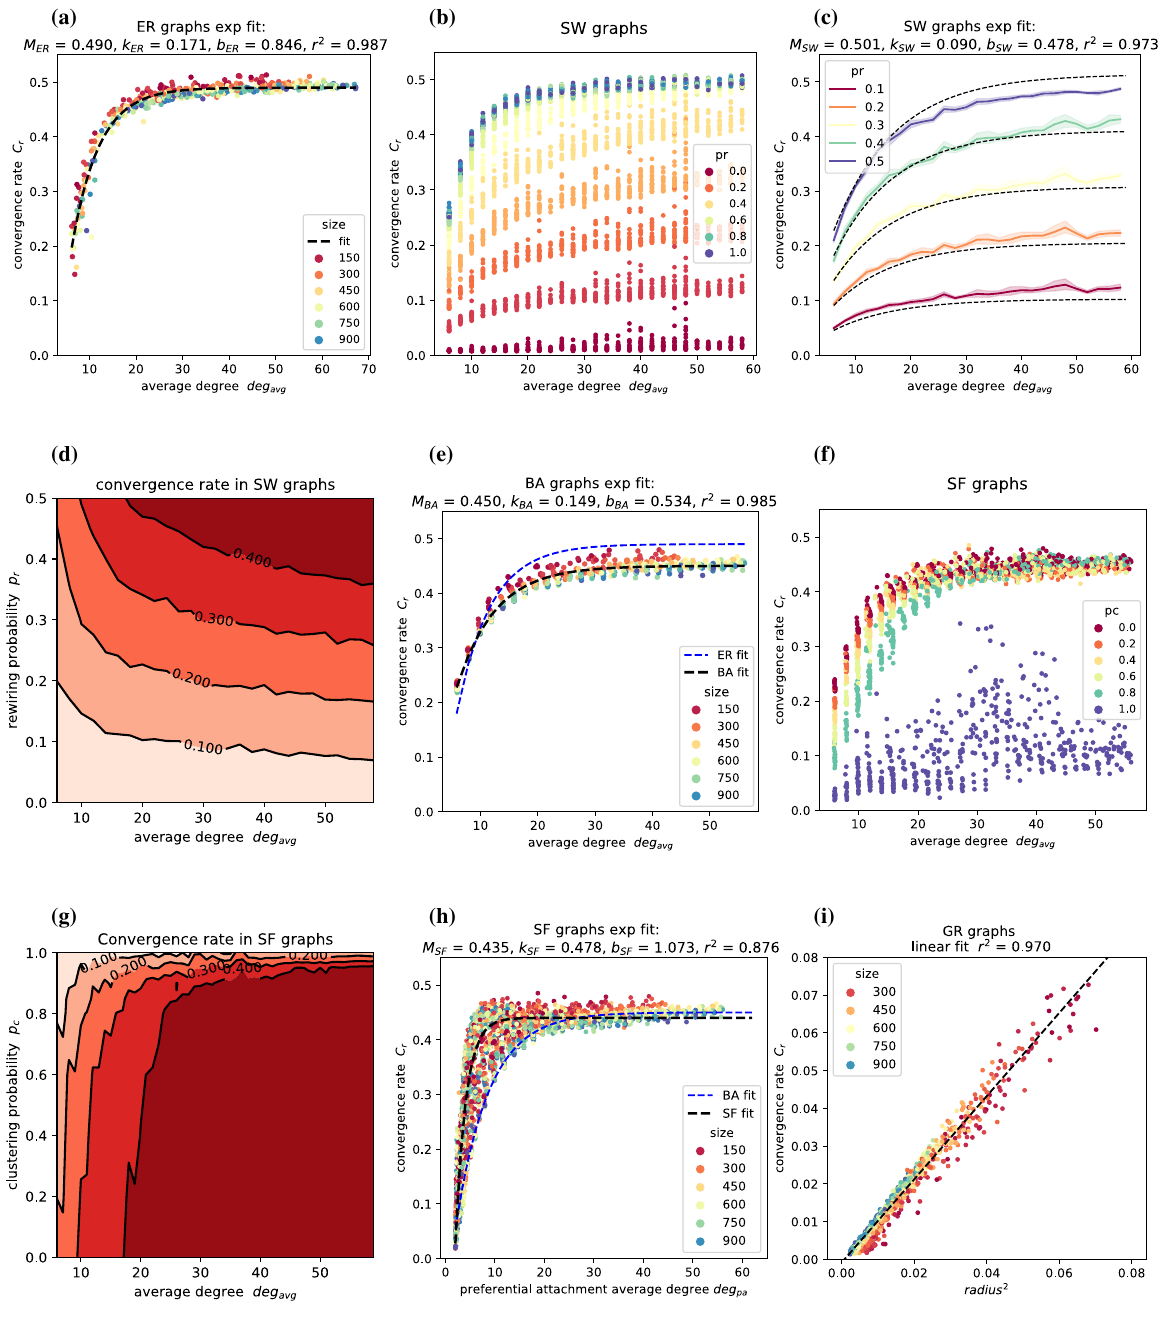
Figure 8. Average degree versus convergence rate and corresponding asymptotic regression model in ( a ) ER graphs, ( b ) SW graphs, ( c ) SW graphs with p r < 0.5, ( e ) BA graphs, and ( f ) SF graphs. Contour plots of = the two parameters of the generative model for ( d ) SW graphs and ( g ) SF graphs. ( h ) Preferential attachment average degree versus convergence rate in SF graphs. ( i ) Radius squared versus convergence rate in GR graphs. Each convergence value is the average convergence rate obtained over 100 simulation